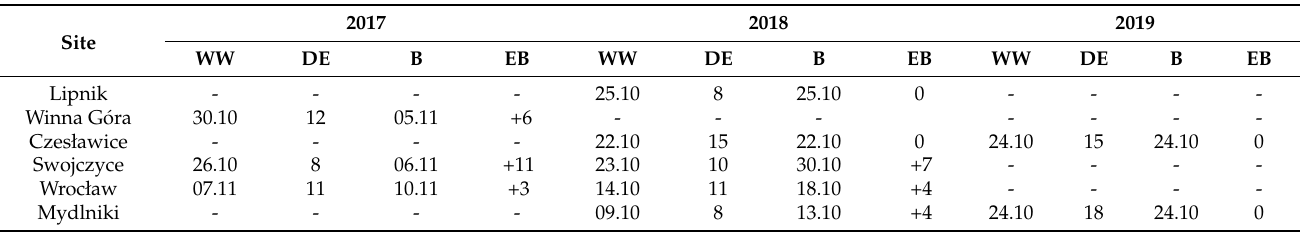
Table 4. Dates of winter wheat and cornflower emergence, and the number of days from wheat sowing until emergence.